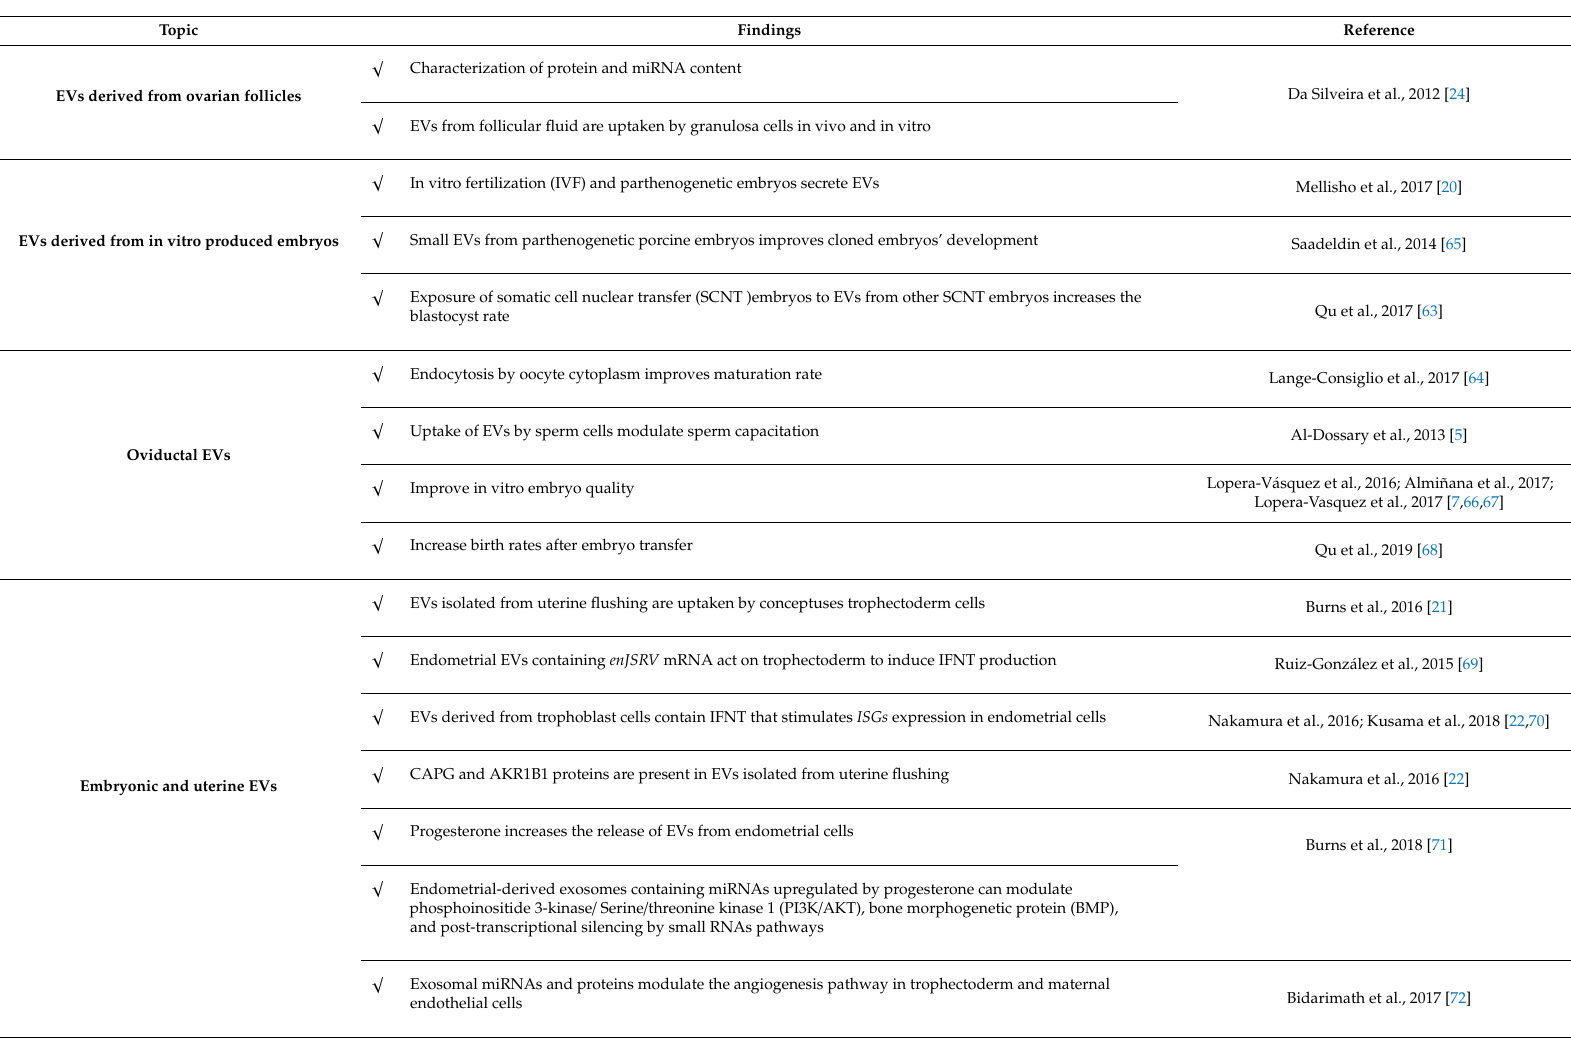
Table 1. Major findings about extracellular vesicles (EVs) derived from the reproductive female tract and embryos in mammals. IFNT: interferon-tau. Topic Findings EVs derived from ovarian